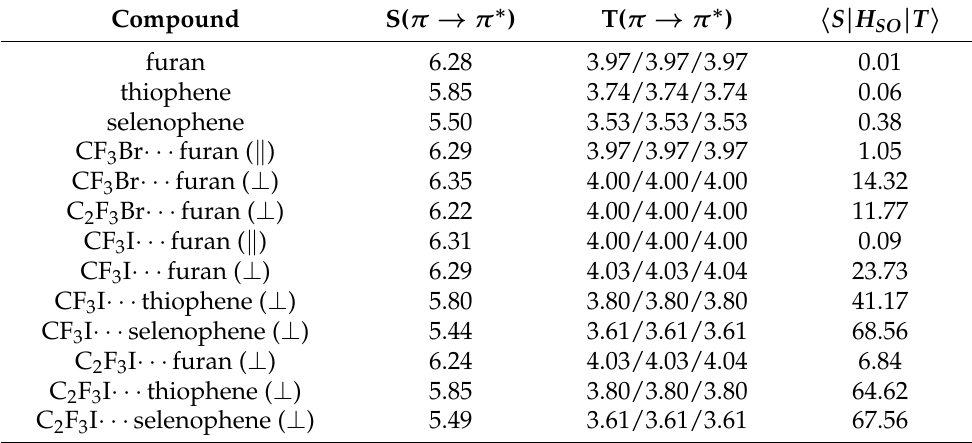
Table 6. Excitation energies (eV) of the bright singlet and dark triplet π → π ∗ states and the spin-orbit coupling matrix element (cm − 1 ) for CF 3 I · · · furan in parallel ( (cid:107) ) and perpendicular ( ⊥ ) orientation.